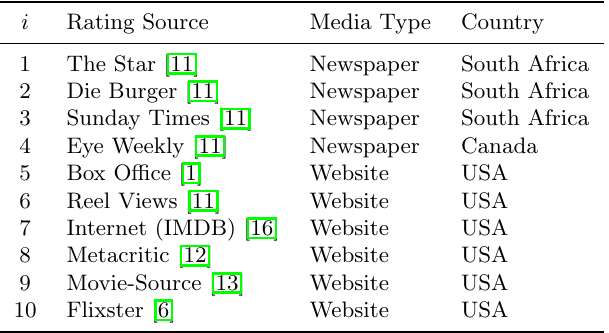
Table 1: Various movie rating